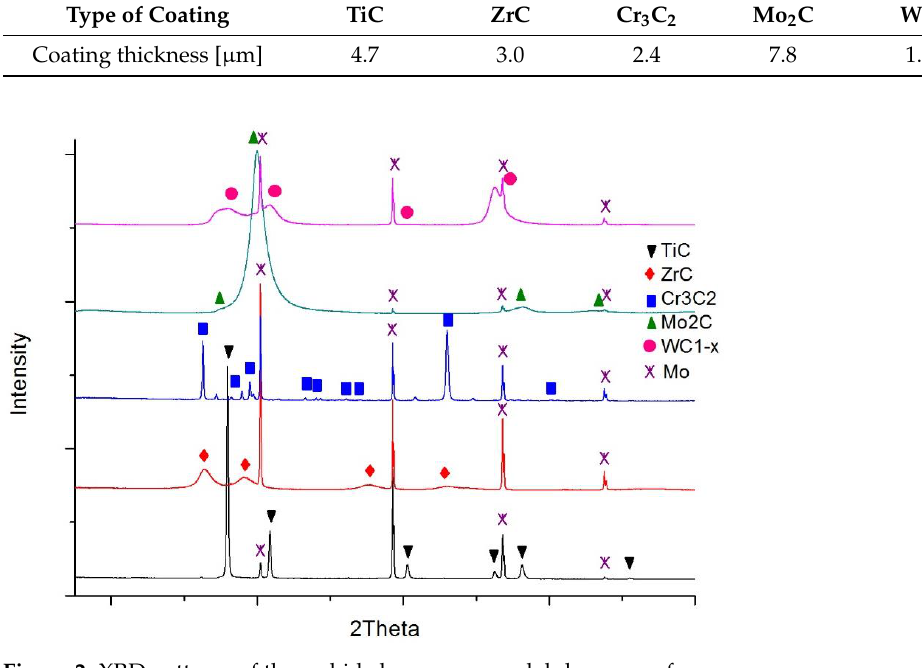
Figure 2. XRD patterns of the carbide layers over molybdenum